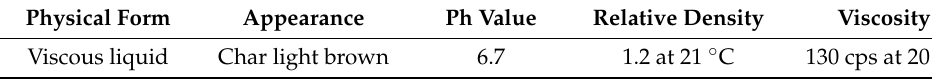
Table 4. Concrete mixture design (mass/cement